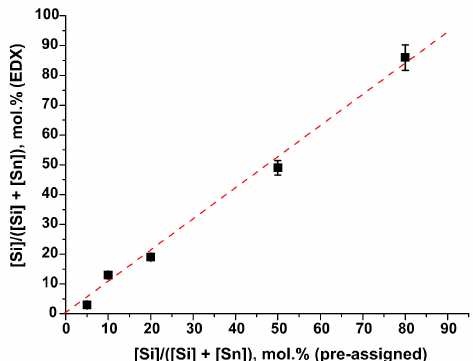
Figure 2. Correlation between silicon content in SnO 2 /SiO 2 nanocomposites determined by EDX and pre-assigned during the synthesis.